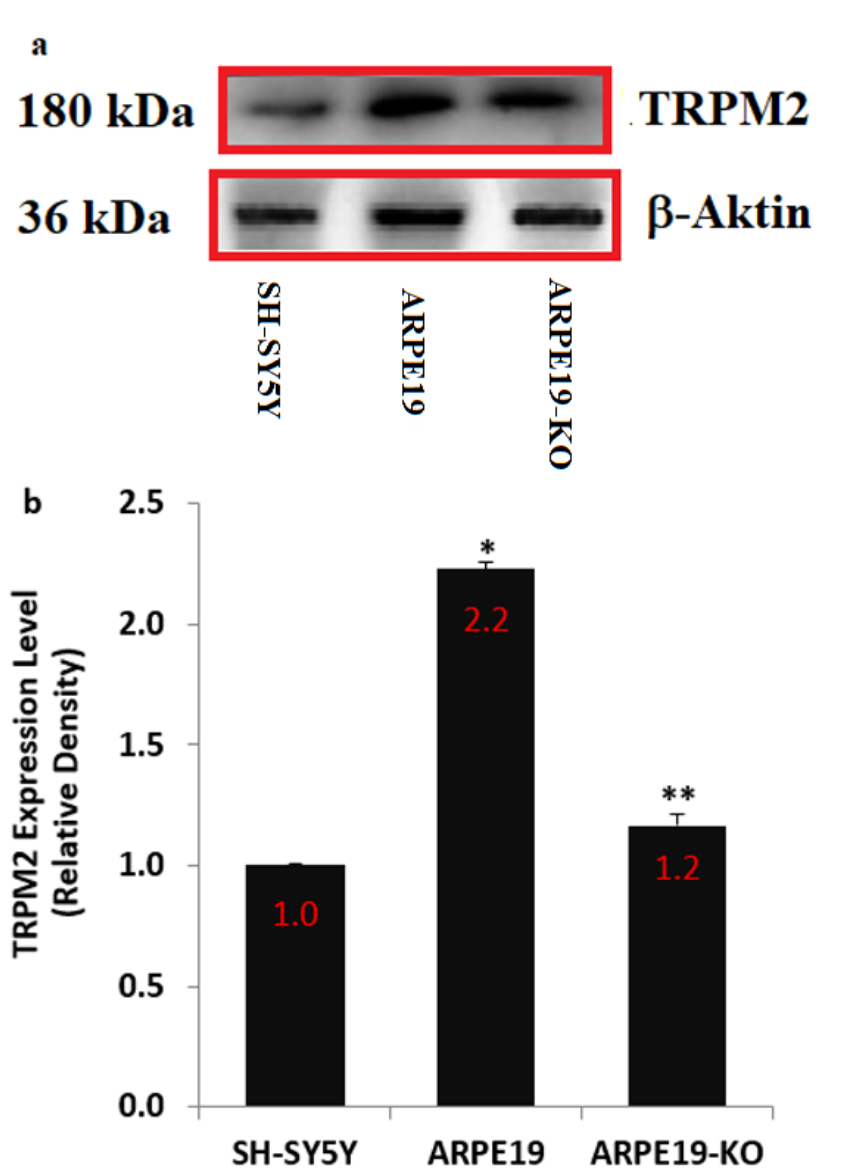
Figure 1. The expression level of TRPM2 protein . (Mean ± SD and n = 3). For the expression levels of TRPM2 protein in the cells of SH-SY5Y, ARPE19 and ARPE19-KO, we used standard Western blot analyses. The protein bands of β -actin were used as control. ( a ) The protein bands of β -actin and TRPM2. ( b ) The mean levels of the band proteins in the column figure were expressed as Mean ± SD. 1:500. (* p ≤ 0.05 vs. SH-SY5Y cells. ** p ≤ 0.05 vs. ARPE19 cells). Treatments of PARP-1 Inhibitors (PJ34 and DPQ), TRPM2 Blocker (2APB) and GSH The current data indicate that the DNA-injury induced ADPR is produced in the nucleus of cells by the activation of PARP-1 enzyme [9]. The presence of ADPR pyrophos- phatase enzyme in the C terminal NUDT9 homology domain of the TRPM2 was reported in the kidney cells (HEK293) [35,36] and ARPE19 cells [21,23]. The ADPR is intracellularly produced in the nucleus of cells by the enzymatic activity of PARP-1 [9]. However, the production of ADPR is reduced by the down-regulation of PARP-1 enzyme. The PJ34 and DPQ are well-known PARP-1 inhibitors [37] and their treatment induced the TRPM2 modulator action in the ARPE19 [21,23]. Importance of thiol redox system members such as glutathione (GSH) and selenium were reported on the TRPM2 activation in several cells, including ARPE19 [18,21,23], although effects of GSH on the TSPO-mediated